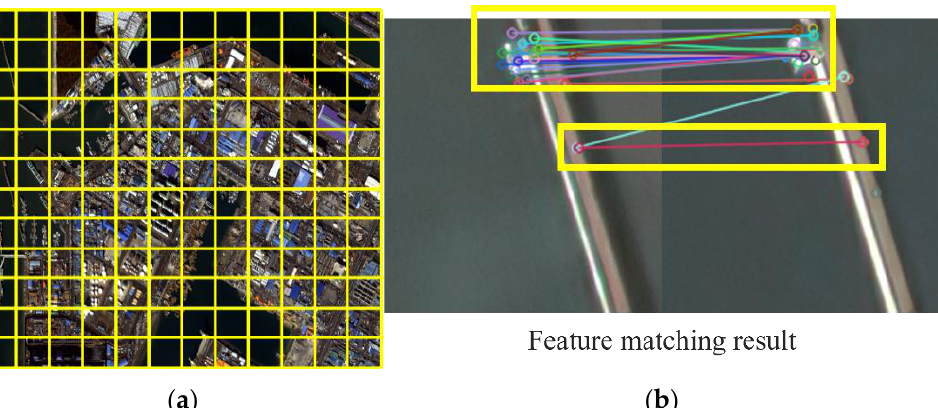
Figure 2. Feature point matching using a bucket: ( a ) bucketing the entire image, and ( b ) feature matching results in one bucket.